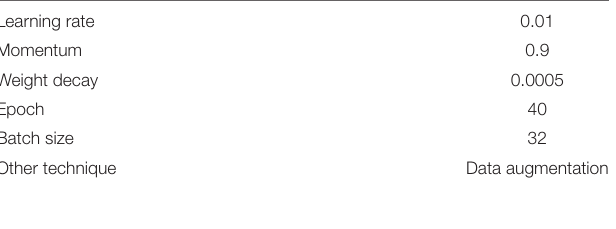
TABLE 2 | Hyper-parameters of ANN quantization training.